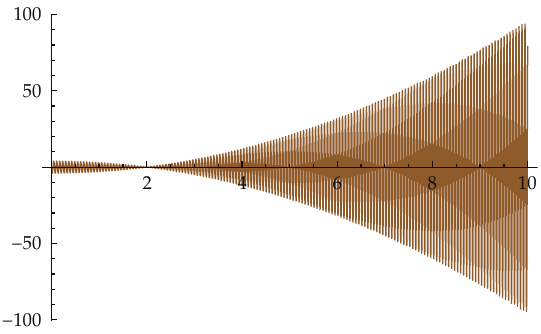
Figure 2: The plot of the function g (cid:2) x (cid:3) including the